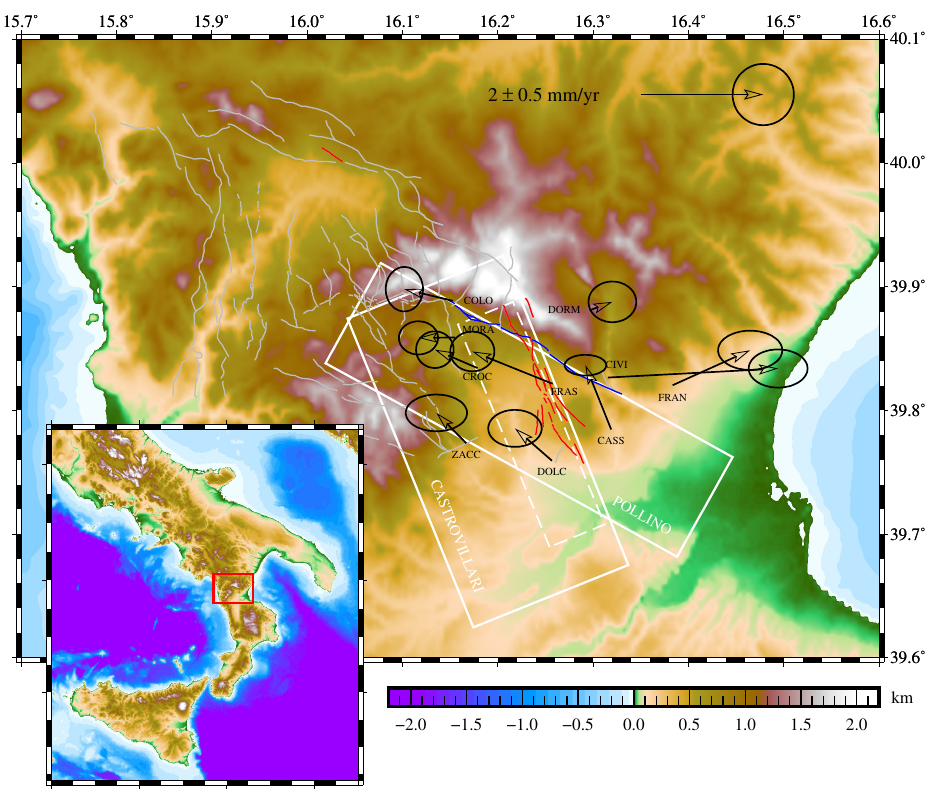
Figure 1. Surface velocities from the GNSS campaigns (in Apulia fixed reference frame, black arrows) from Sabadini et al. [25], the fault traces (gray, red and blue lines) identified by Brozzetti et al. [26] and the Castrovillari and Pollino faults used in this study (white solid rectangles). Red and blue lines are the fault traces associated with the Castrovillari and Pollino faults, respectively, and the white dashed rectangle indicates the Castrovillari fault from the Database of Individual Seismogenic Sources [27]. The top edge of the DISS fault is slightly shifted southwestward because is at 1km depth rather than at the Earth surface. The topography of the area is shown in the background and the inset shows the south Italy and the location of the plotted region (red